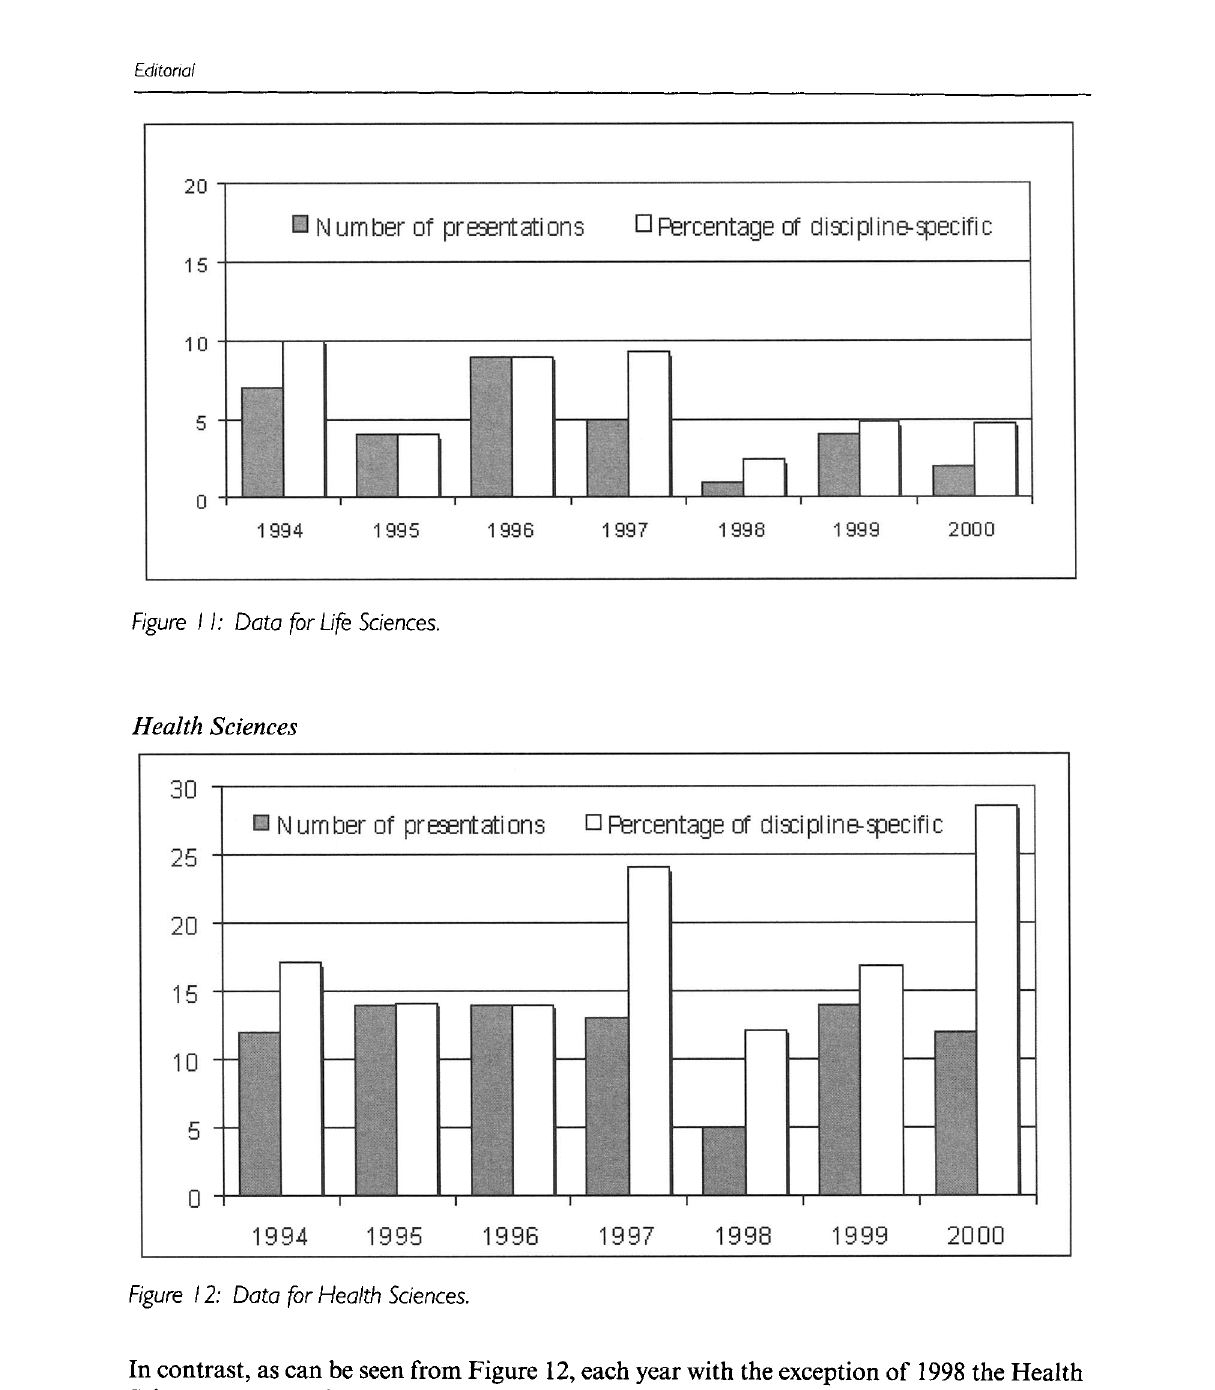
Figure 12: Data for Health